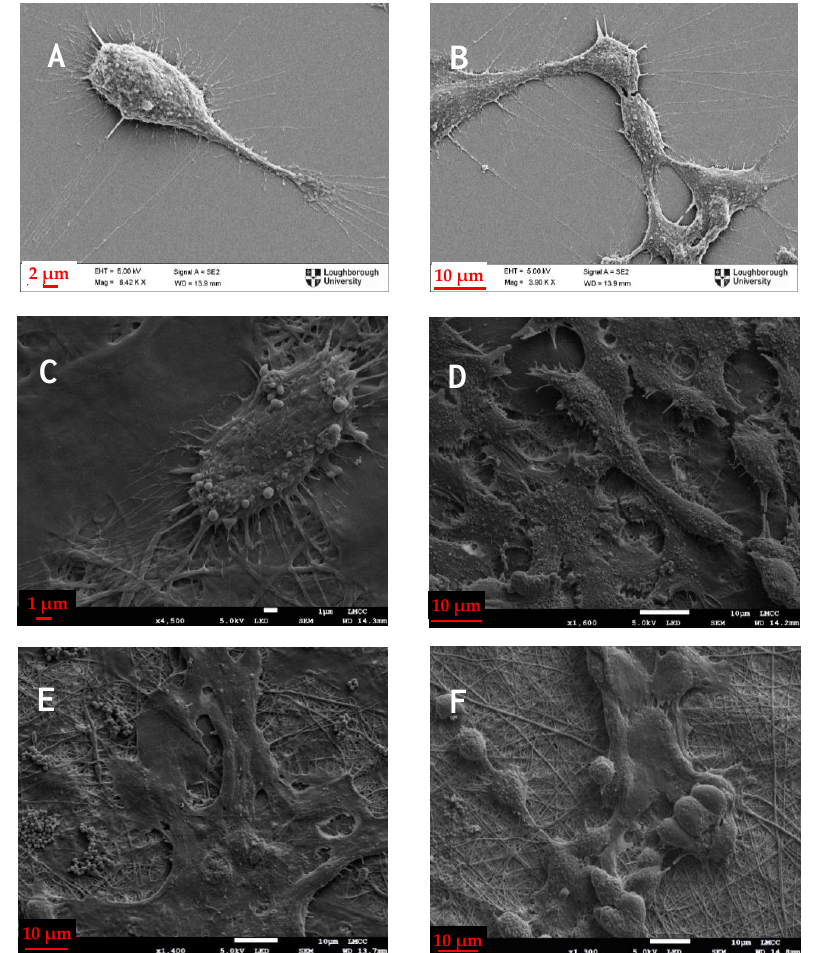
Figure 7. Scanning Electron Microscope Images of: ( A , B ) osteoblasts on glass slide; ( C ) 1:3 PANI/CS membrane; ( D , E ) 3:5 PANI/CS membrane; and ( F ) 1:1 PANI/CS membrane.